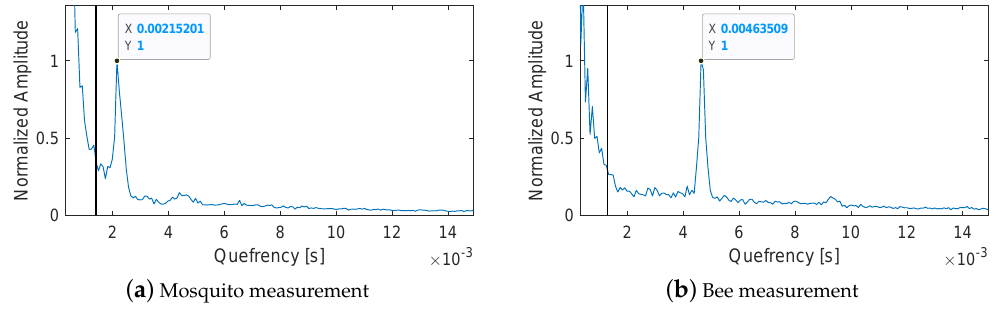
Figure 11. Projected cepstrogram of a mosquito measurement ( a ) and of a bee measurement ( b ). The black vertical lines in these plots mark the lower limit q l of the analyzed quefrency range.